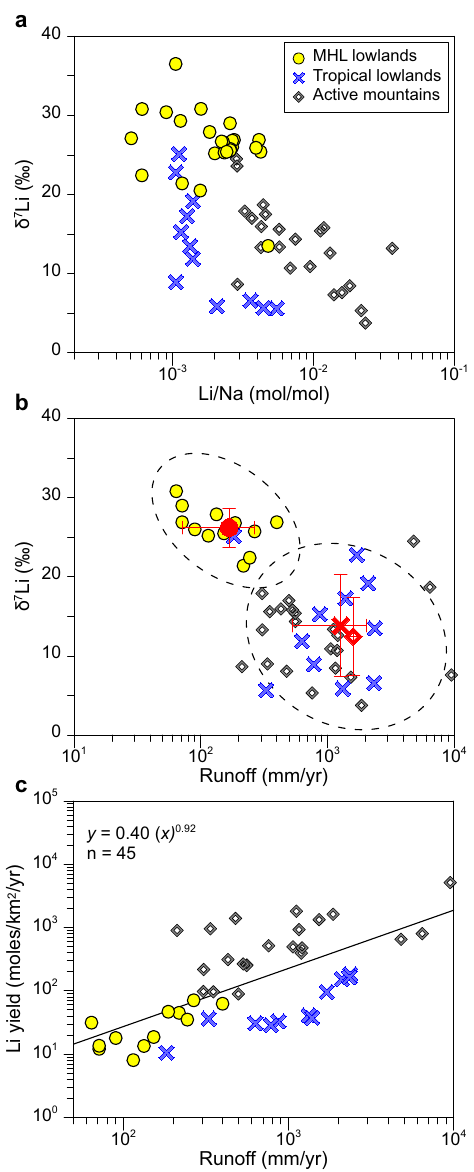
Fig. 3 Riverine δ 7 Li and Li yield from various geological settings. ( a ) δ 7 Li versus Li/Na. Tropical lowlands (blue crosses) and mountain areas (grey squares) show similar δ 7 Li values, but have lower δ 7 Li than middle-to-high latitude (MHL) lowlands (yellow dots). ( b ) δ 7 Li versus runoff, showing an overall negative correlation between MHL and tropical lowlands. Red symbols are averages of δ 7 Li and runoff in the MHL (red dot), tropical lowlands (red cross) and mountain areas (red square). Red errors are standard deviations. Two dashed ellipses cover the majority of the MHL and tropical lowlands, respectively. ( c ) Dissolved Li yield versus runoff, showing higher runoff with higher Li yield. There are fewer data points of MHL lowlands in b and c because no runoff data is available for some rivers. The MHL lowland dataset includes 27 rivers draining the Greenland Shield, Canadian Shield, Siberian Shield, and Baikal Rivers. The tropical lowland includes 12 rivers draining the Amazon Shield, Orinoco Shield, and the Congo River. The active mountain dataset includes 25 rivers draining the Andes, New Zealand Alps, Himalaya, Rocky and the Mackenzie Mountains, and upstream of the Yangtze, Mekong, and Salween Rivers (see